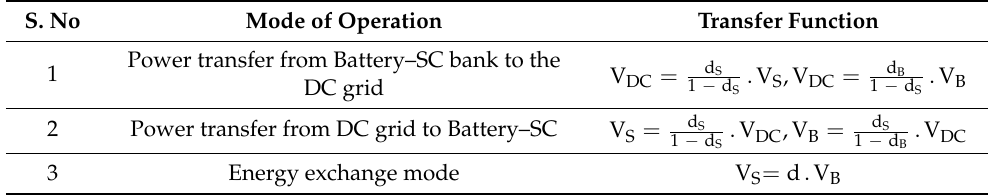
Table 3. Relationship between different voltages.